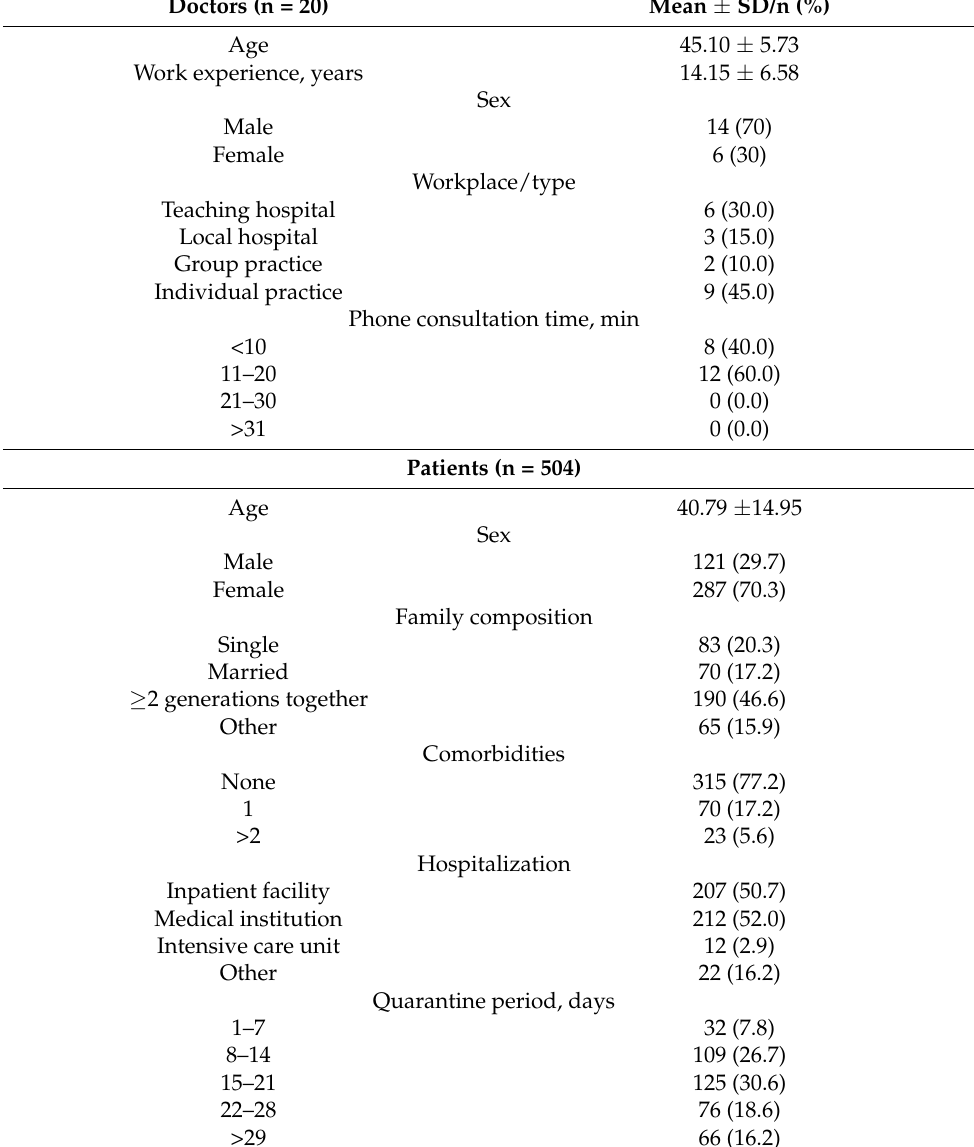
Table 3. Descriptive statistics of participating doctors and